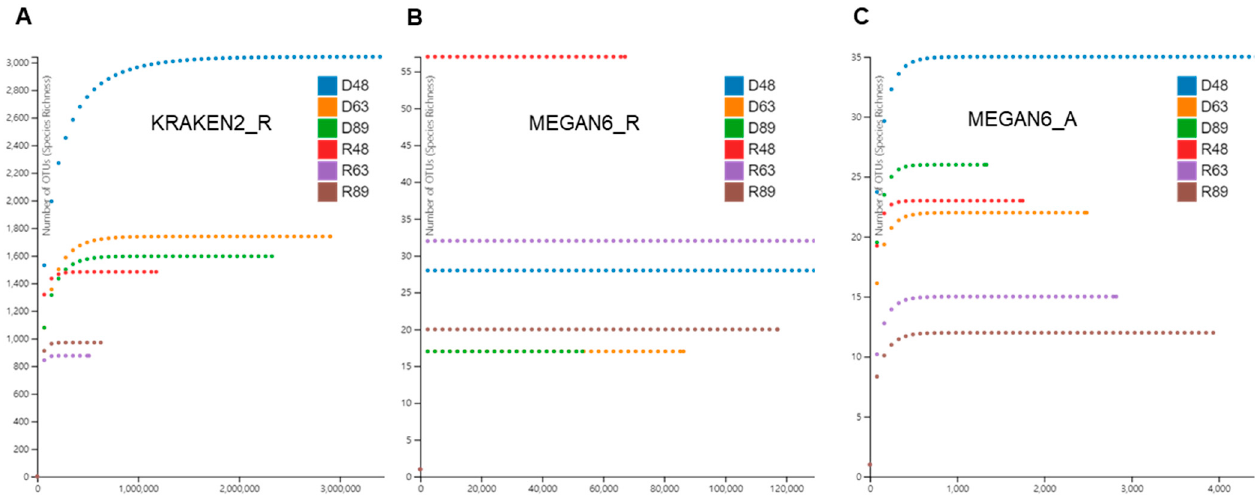
Figure 3. Rarefaction curves of microbiomes in overwintering pepper fruits using three different analytical methods: KRAKEN2_R ( A ), MEGAN6_R ( B ), and MEGAN6_A ( C ).